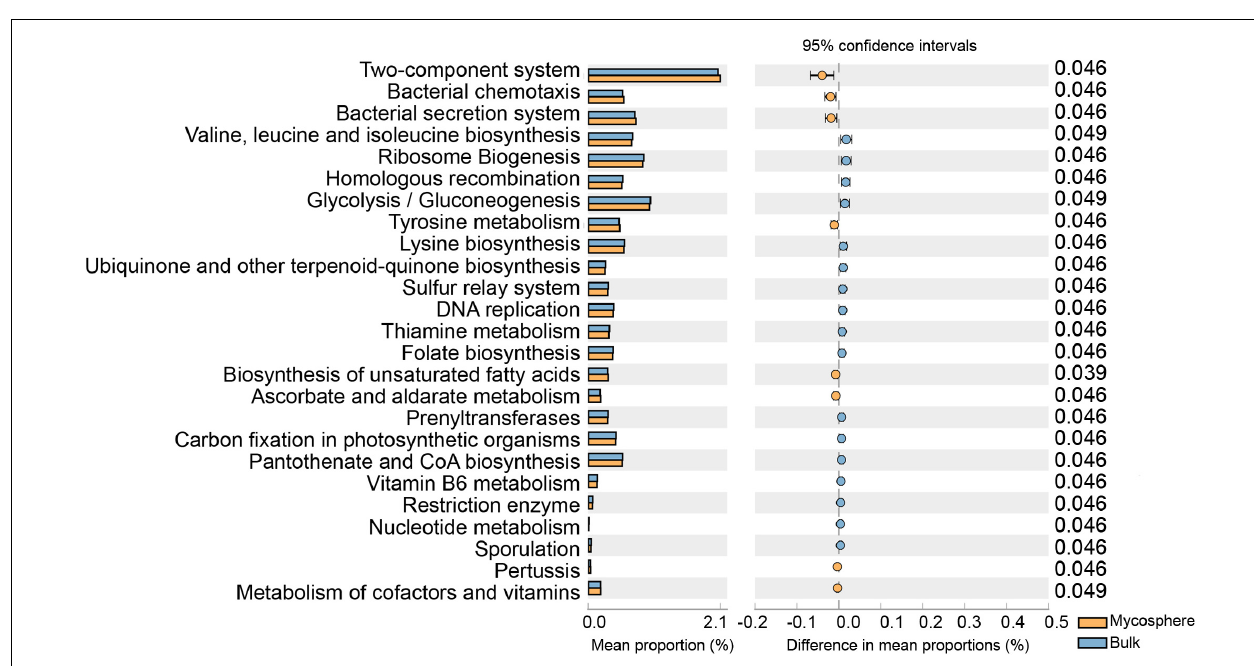
the bacterial soil. Our results indicated that mycospheres and bulk soils were functionally distinct. Mycosphere soils had an increase in the two-component system, bacterial chemotaxis,